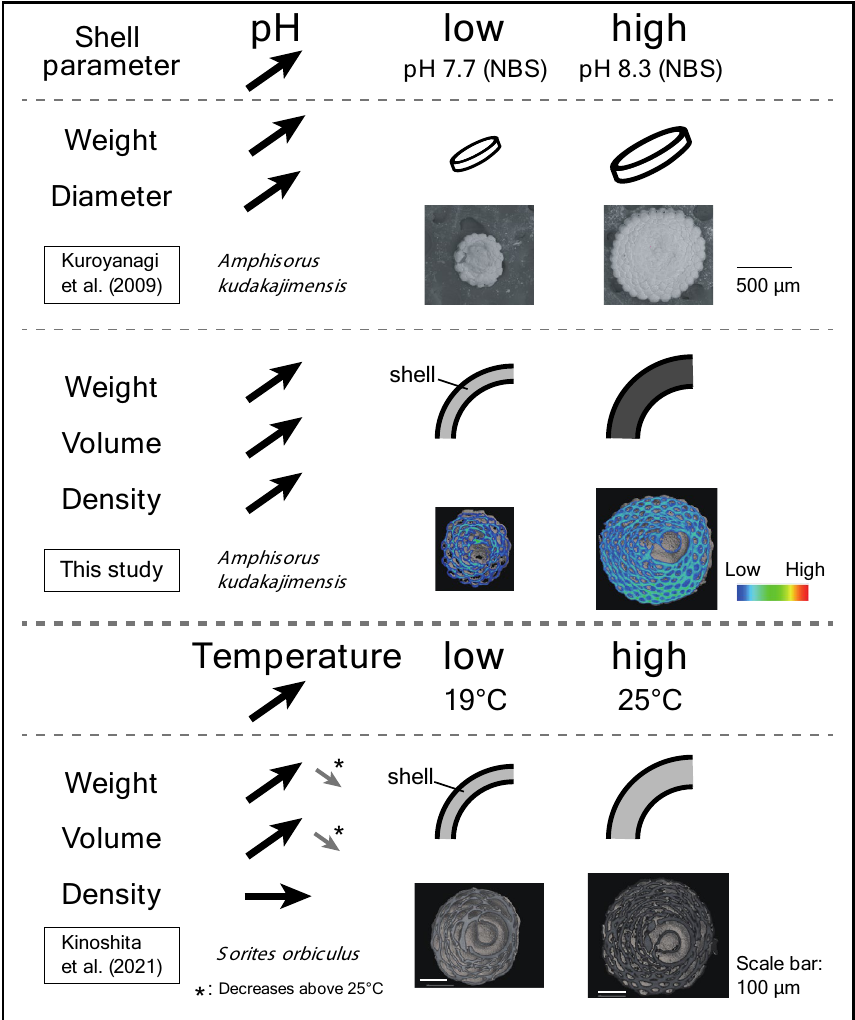
Figure 2. The relationship between shell parameters (weight, diameter, volume, and density) of cultured Soritinae ( Amphisorus kudakajimensis and Sorites orbiculus ) and pH and water temperature. MicroCT photo was created using the 3D image processing software Molcer Plus (ver. 1.6, White Rabbit Corp., Tokyo, Japan). The color of the MicroCT photo (#37 and #85 samples) represents the X-ray absorption coefficient (i.e., warm colors mean relatively high